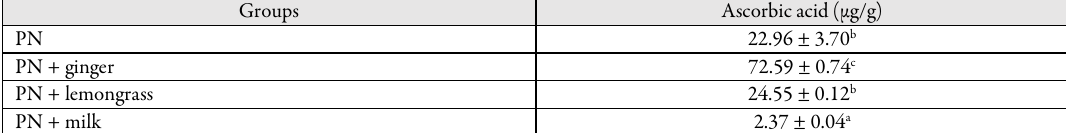
Table 3. Ascorbic acid content of infused extracts of Parquetina nigrescens leaf with additives Groups